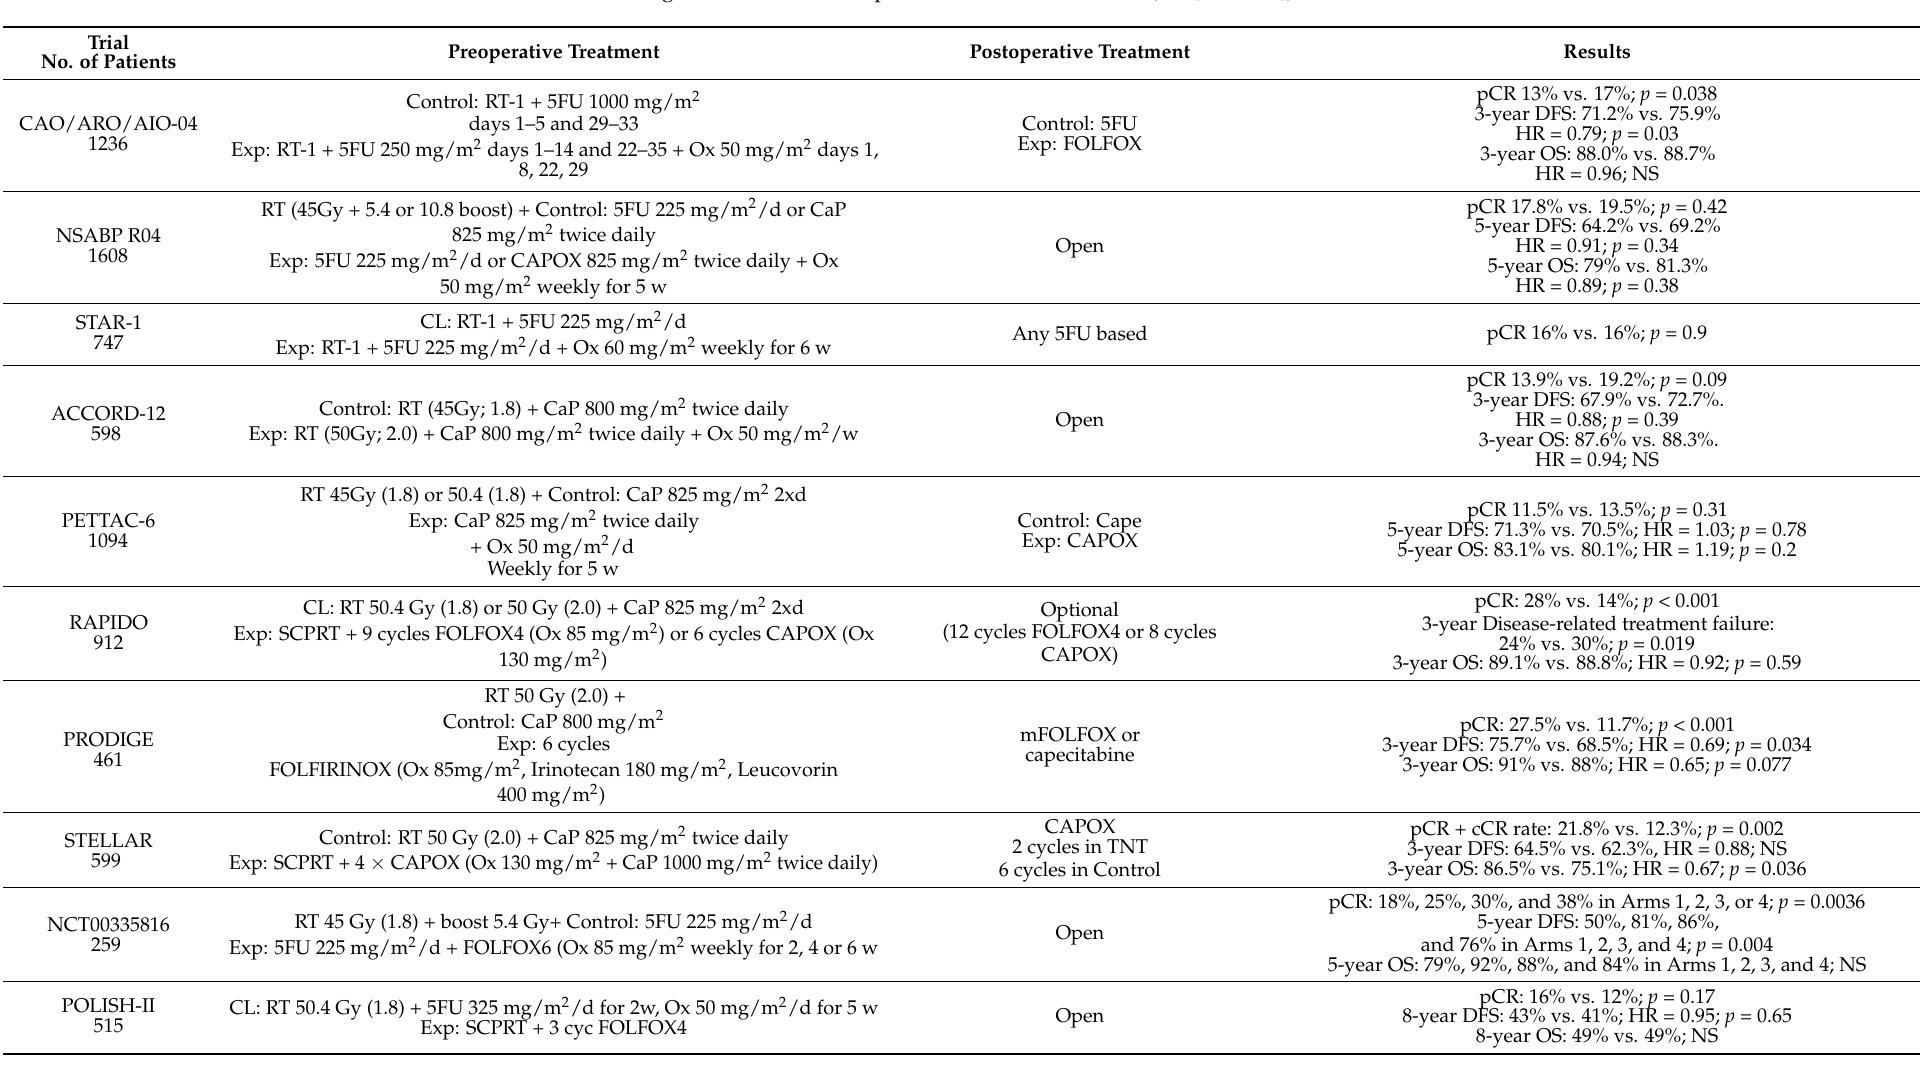
Table 3. Clinical trials that investigate the Role of Oxaliplatin-Based RCT and TNT (Cf. [14,26,33]). Trial No. of